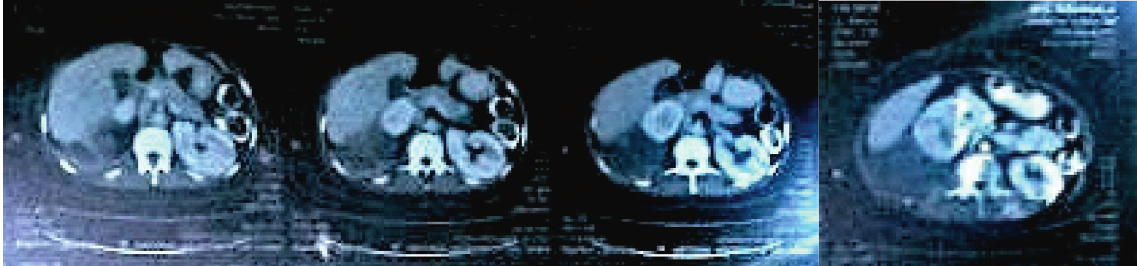
Figure 2: MRI obtained on the 5th day following admission. Temperature chart